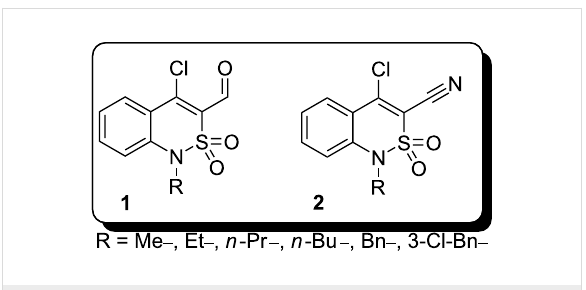
Figure 1: Benzo[ e ][2,1]thiazine-4-chloro-3-carbaldehydes 1 and benzo[ e ][2,1]thiazine-4-chloro-3-carbonitriles 2 .